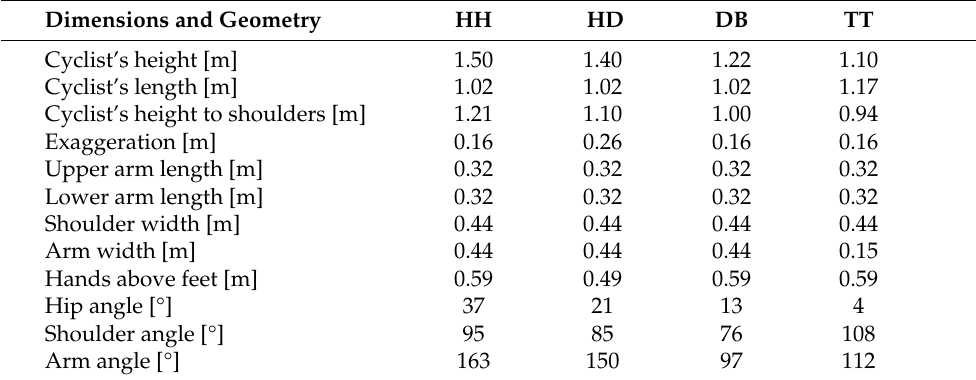
Table 1. Cyclist’s dimensions and geometry.